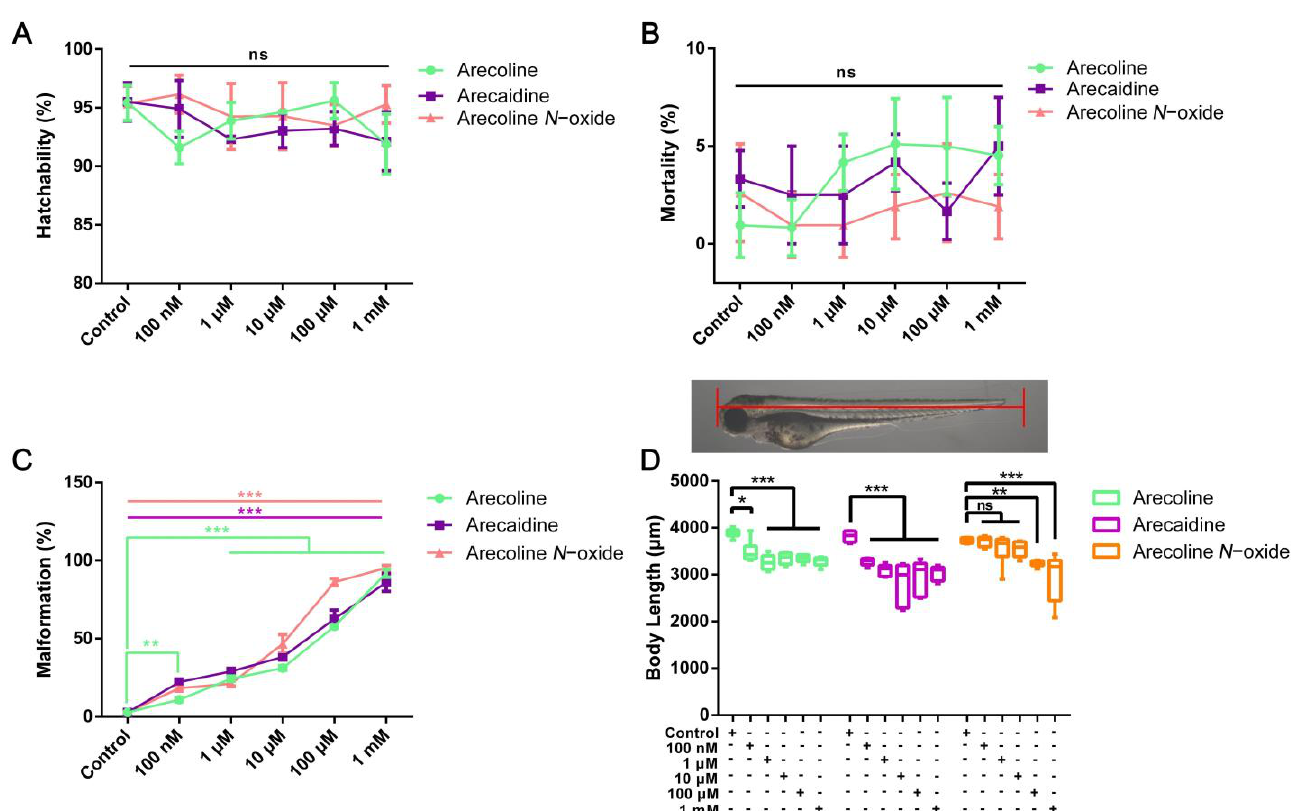
Figure 1. The effects of arecoline, arecaidine and arecoline N -oxide on embryonic development of zebrafish. ( A ) Hatchability of embryos at 72 hpf. ( B ) Mortality of zebrafish at 96 hpf. ( C ) Malformation rate of the larvae at 96 hpf. ( D ) Body length of the larvae at 96 hpf. Values are presented as the mean ± SD ( n = 3). Asterisks denote significant differences between treatments and the control (*, p < 0.05; **, p < 0.01; ***, p < 0.001, ns means no significance). The mean, SD, p value and corresponding significance are shown in Tables S1–S4.